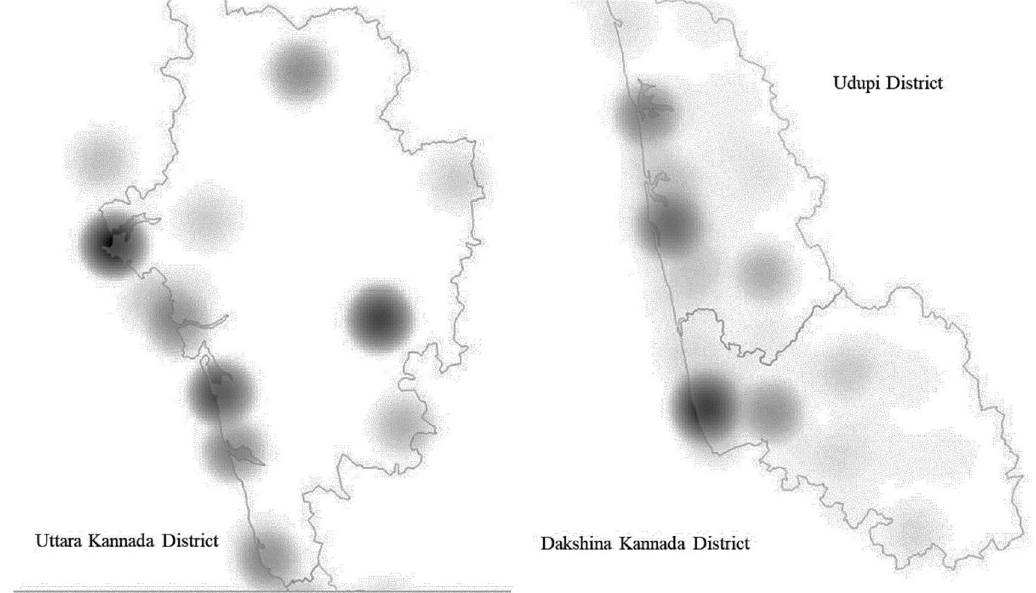
Figure 3. Heat map/Density Map showing the concentration of Oral health care facilities of 3